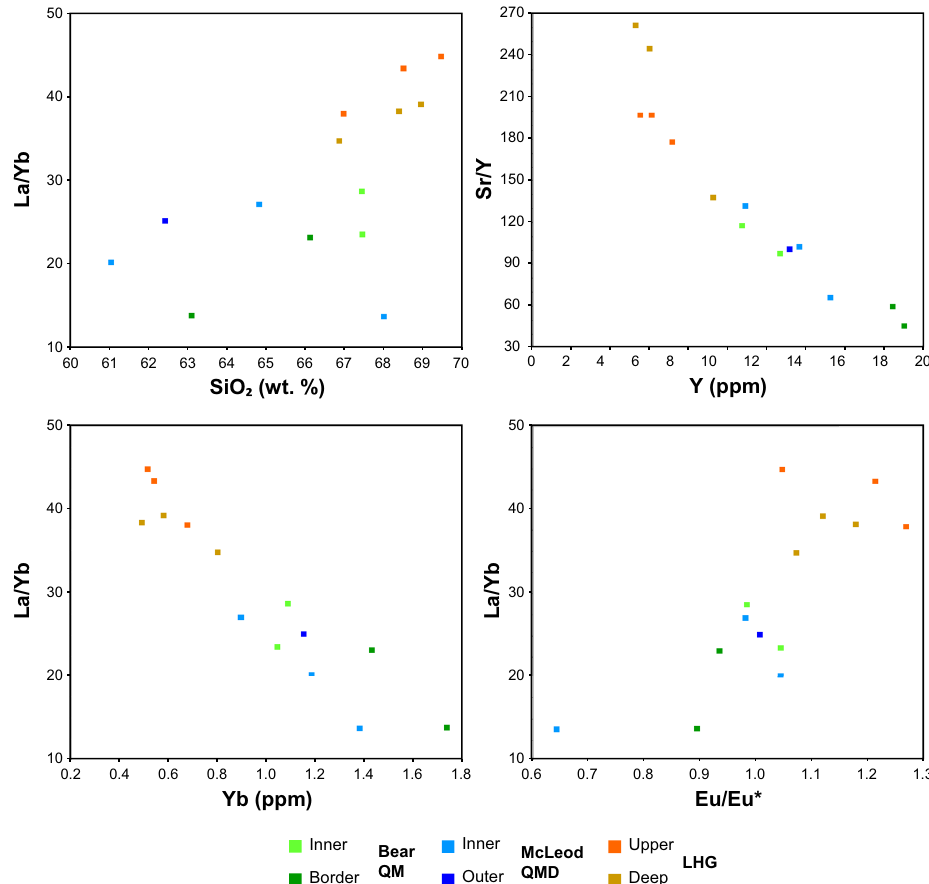
Figure 6. Whole-rock geochemical compositions of plutonic units in the Yerington magmatic system. Major elements in part overlap between the mineralogically distinct 27 intrusive units. Distinct differences between pre- mineralisation (Bear QM and McLeod QMD) and inter-mineralisation (LHG) units are seen in trace element ratios. Porphyry and aplite dykes plotted in Fig.